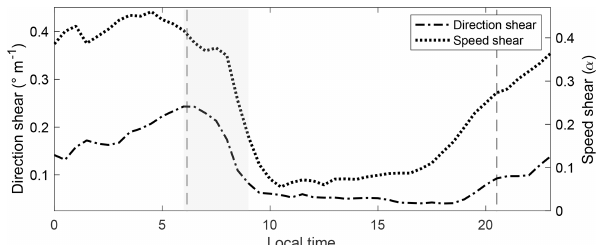
Figure 9. Diurnal cycle of mean wind direction and speed shear for wind speeds between cut-in and cut-out. Dashed vertical lines indicate sunrise and sunset times for 1 August 2013, the midpoint of the dataset analyzed here. The grey shaded region indicates the morning transition period